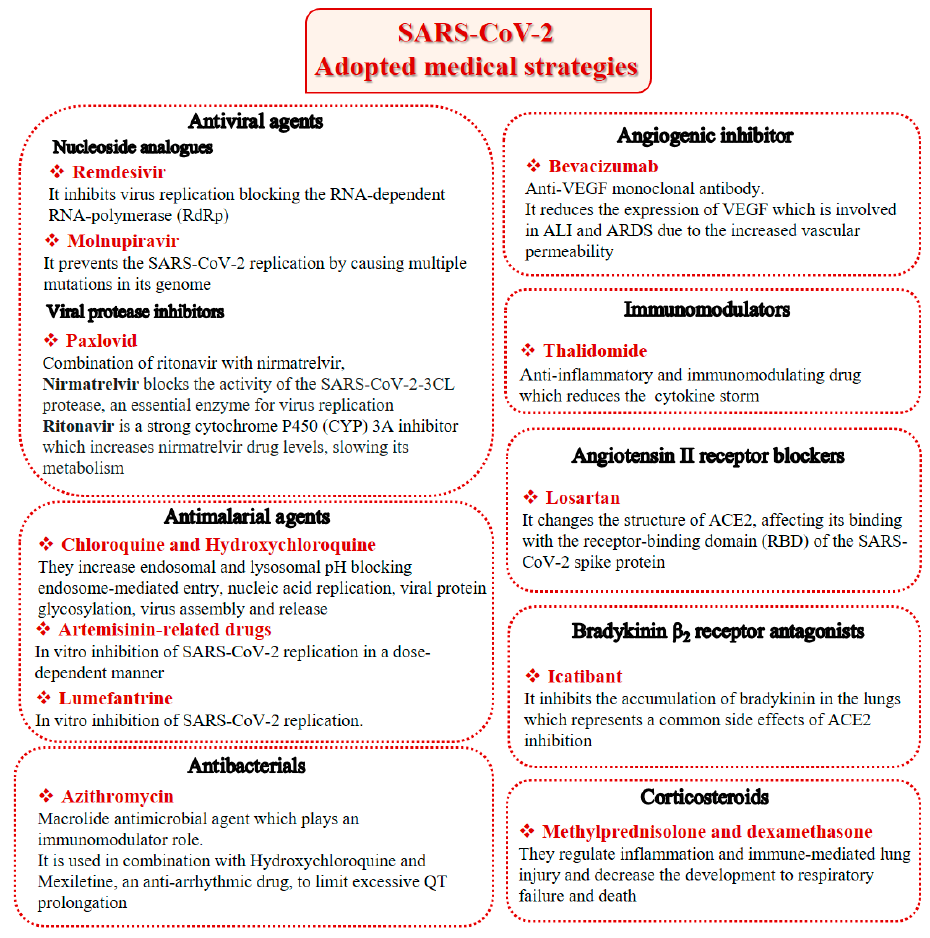
Figure 2. SARS-CoV-2 adopted medical strategies.